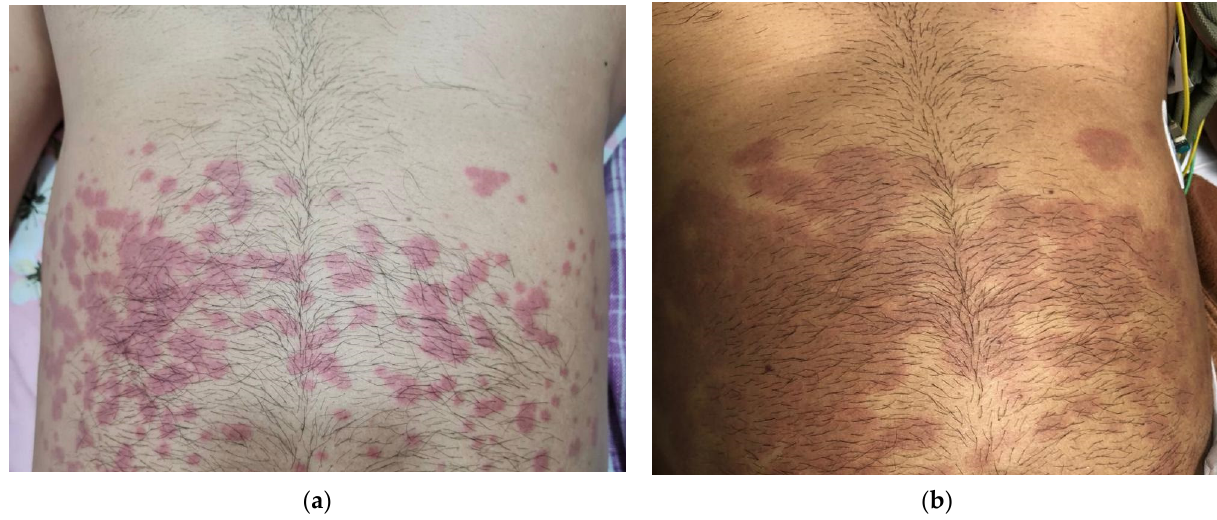
Figure 1. The evolution of a vasculitic rash. ( a ) Progression and clustering of the erupted maculopapular rash on the second day of illness; ( b ) desquamation with coalescence of an erythema multiforme-like lesion on the anterior surface of the abdominal wall upon presentation to the hospital (day six of illness).